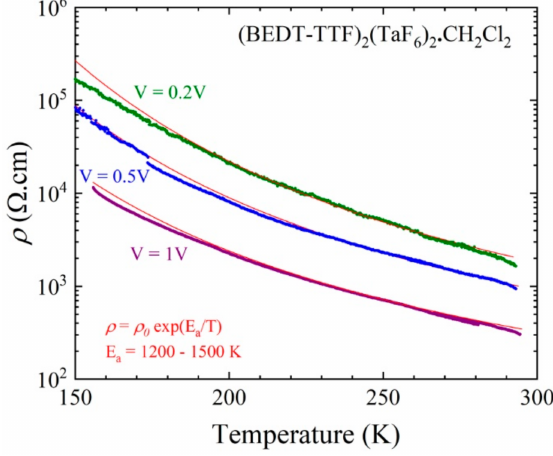
Figure 12. Temperature dependence of the electrical resistivity of a single crystal (#3) of (BEDT- 1 V. The red line is the linear fit to the data giving the activation energy E a .